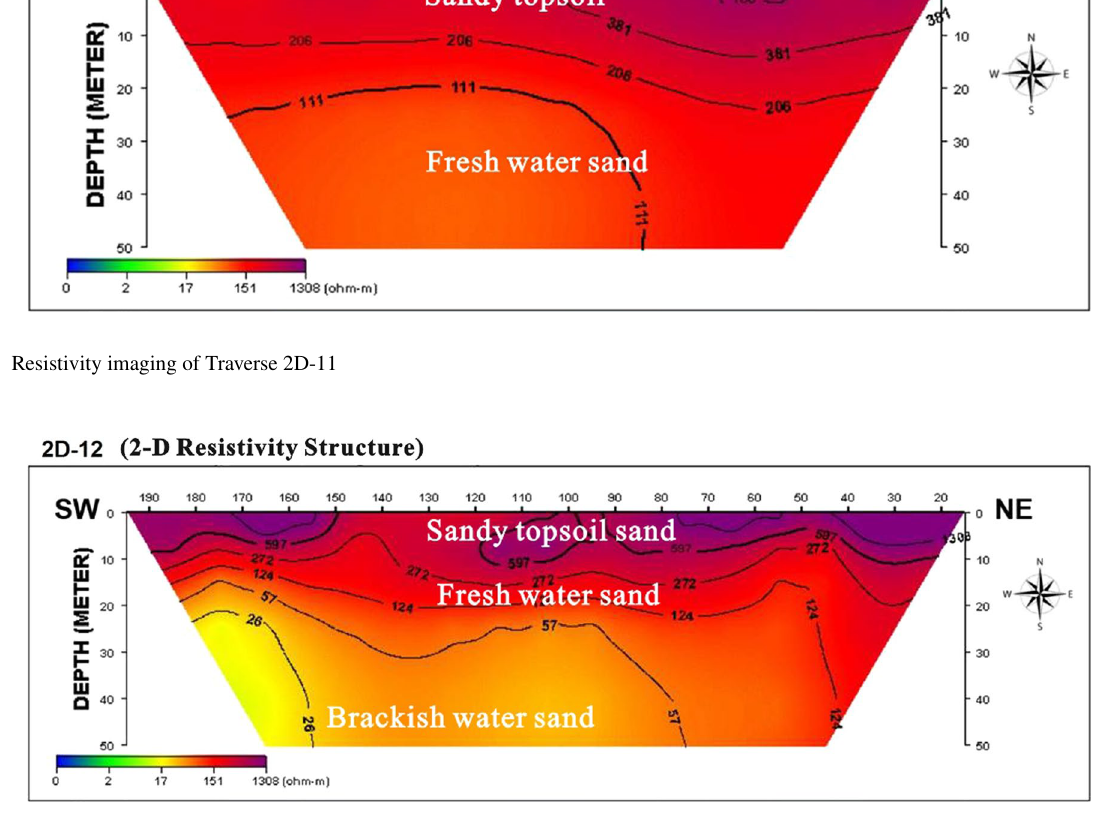
Fig. 16 Resistivity imaging of Traverse